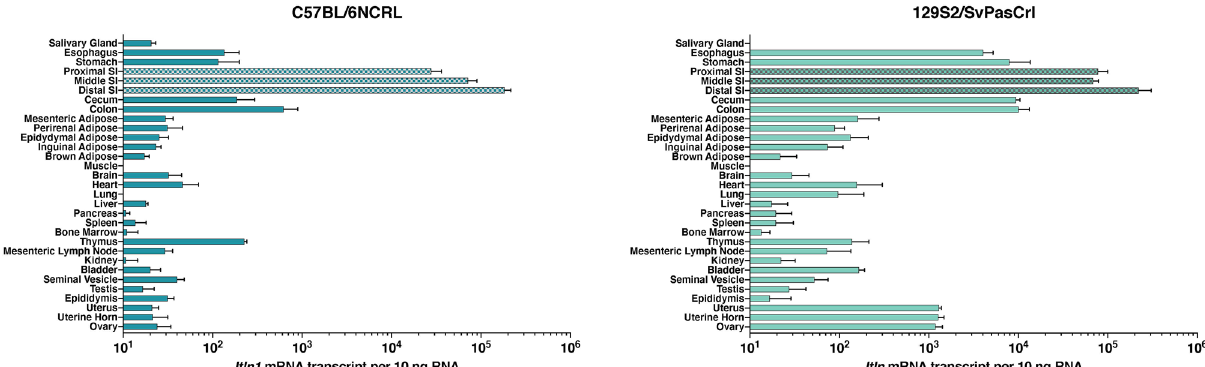
Figure 2. Analysis of intelectin expression in mice. mRNA expression levels measured by RT-qPCR are shown across tissues for (a) Itln1 in C57BL/6NCRL and (b) all intelectins in 129S2/SvPasCRL. Absolute quantification of mouse Itln mRNA transcript counts from tissue samples (two technical duplicates for each of four mice) determined from standard curves using a sequence specific plasmid and presented as transcripts per 10 ng